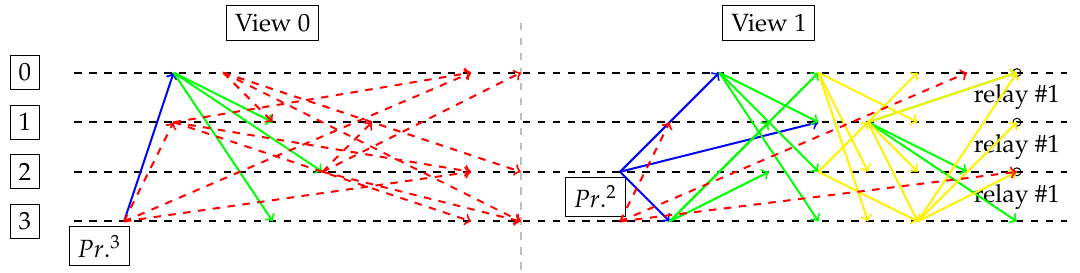
Figure 4. Scenario P7 with N = 4 and message reception with all Properties ( 1 )–( 4 ). Optimal value is 707, a block is generated and byzantine was only able to delay the liveness for a single round. Figure 5 graphically indicates the behavior of the Byzantine system on the P1